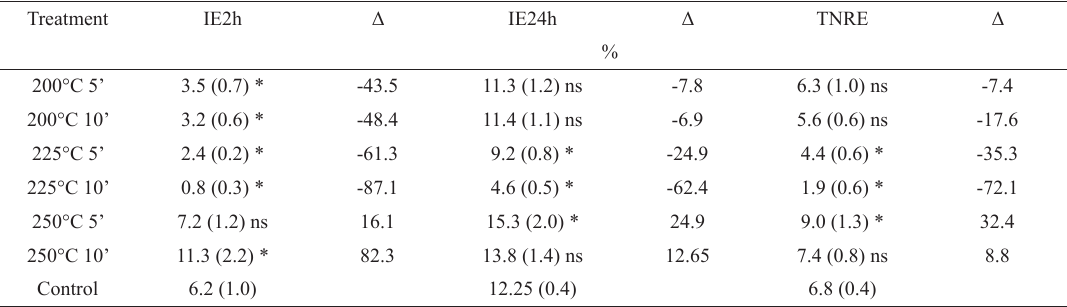
Table 5: Average values of the swelling thickness of the MDF after two and twenty-four hours of immersion and the thickness no return rate. Treatment IE2h